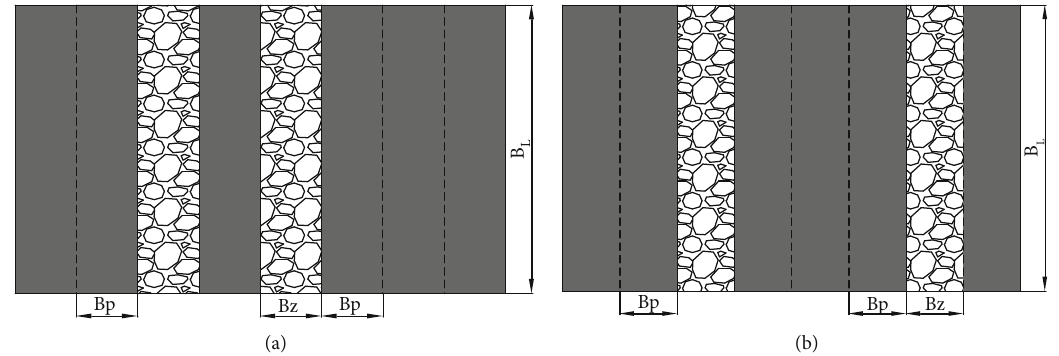
Figure 2: The stress analysis of coal pillar in the two mining methods. (a) The stress analysis of coal pillar in sequential mining. (b) The stress analysis of coal pillar in skip mining.